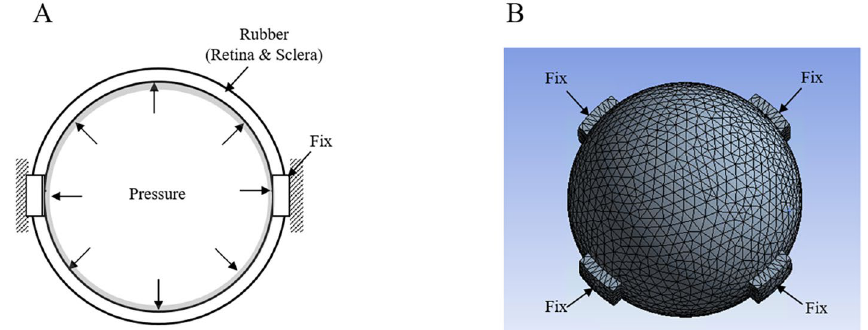
Figure 7. Eyeball FEM analysis ( A ) Eyeball analysis model ( B ) Mesh of the eyeball analysis model. The mesh model was developed using ANSYS 17.2 (http://www.ansys